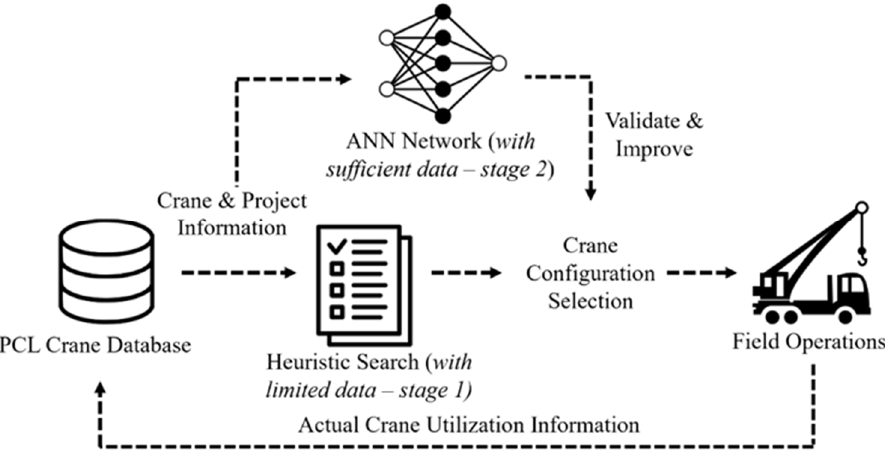
Figure 3. Overall methodology of data-driven crane configuration selection.